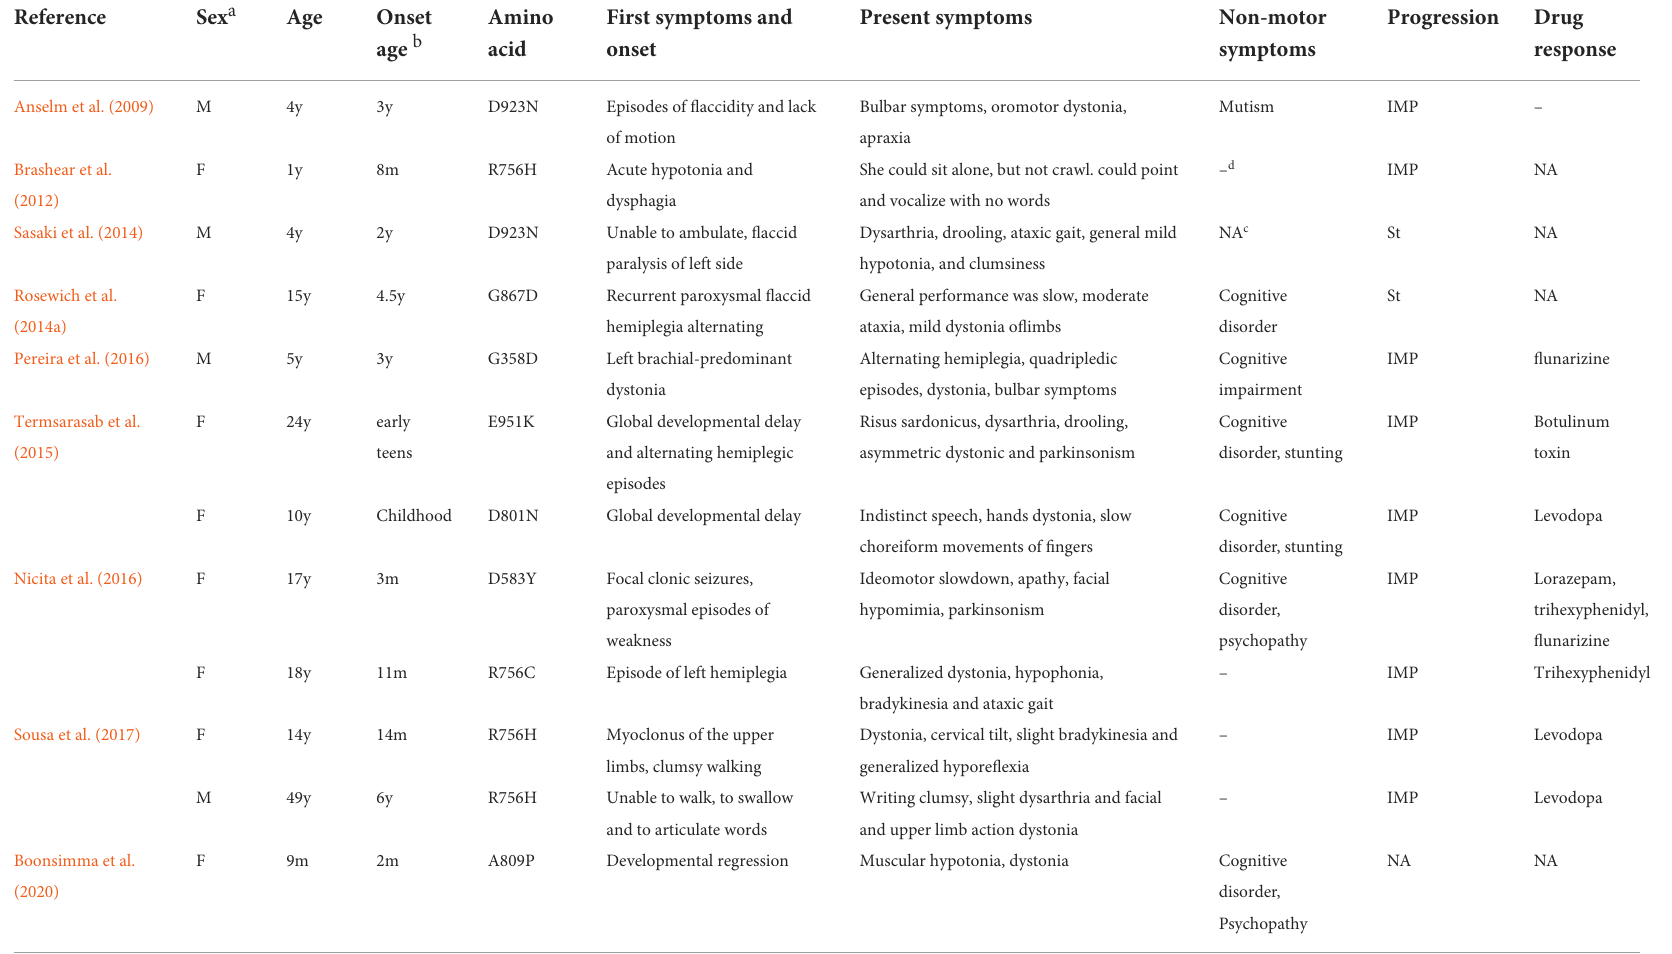
TABLE 2 Summary of the genetic and clinical features of the intermediate AHC/RDP